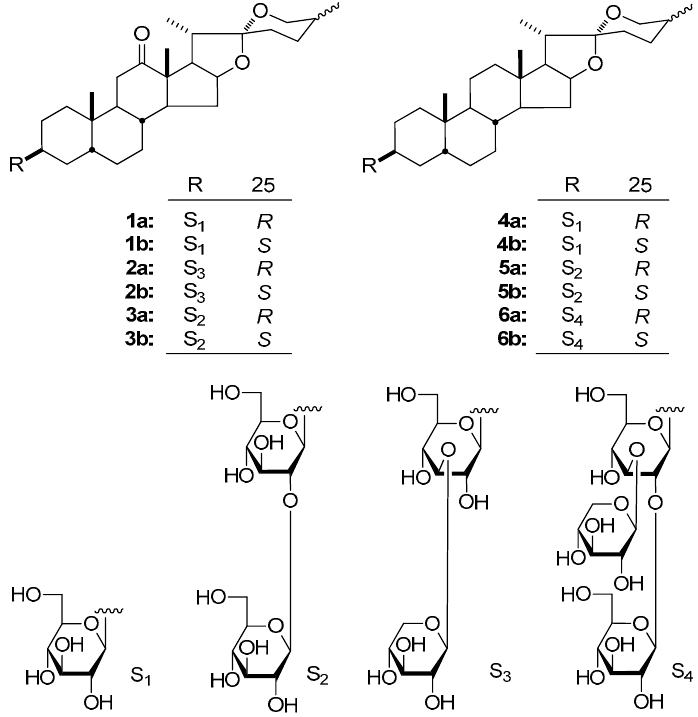
Figure 1. Chemical structures of the spirostanol saponins 1a – 6a and 1b – 6b .